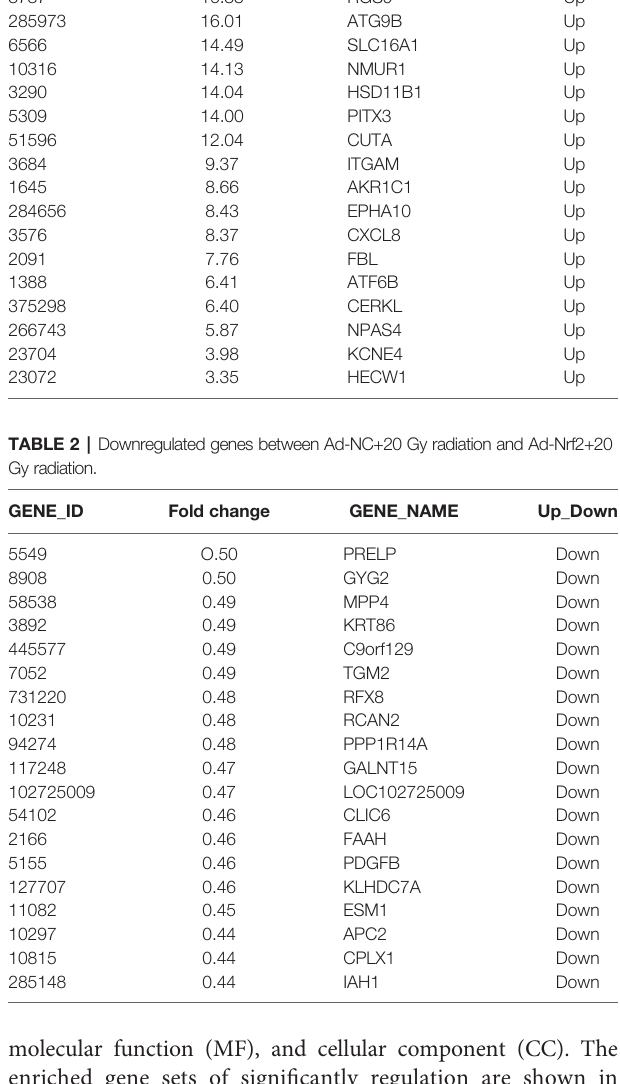
TABLE 1 | Downregulated genes between Ad-NC+20 Gy radiation and Ad-Nrf2+20 Gy radiation. GENNE_ID